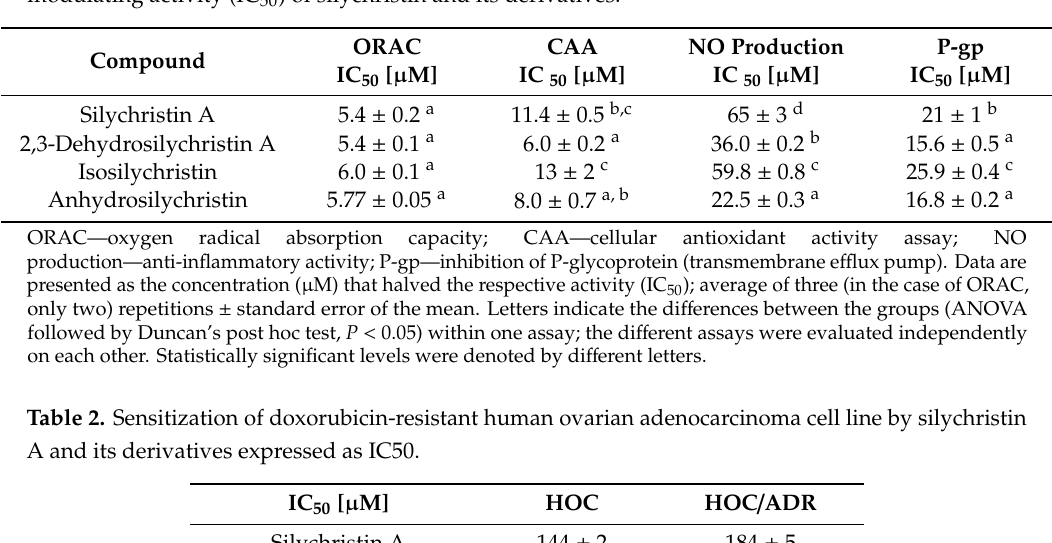
Table 2. Sensitization of doxorubicin-resistant human ovarian adenocarcinoma cell line by silychristin A and its derivatives expressed as IC50.